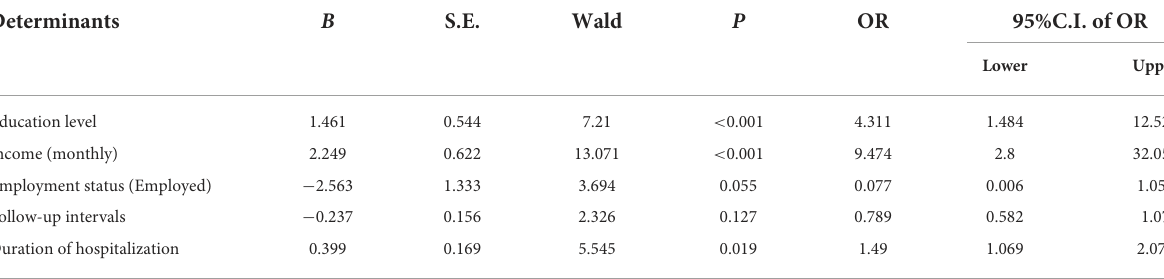
TABLE 4 Multiple logistic regression of influencing factors among KD caregivers. B S.E. OR 95%C.I. of OR